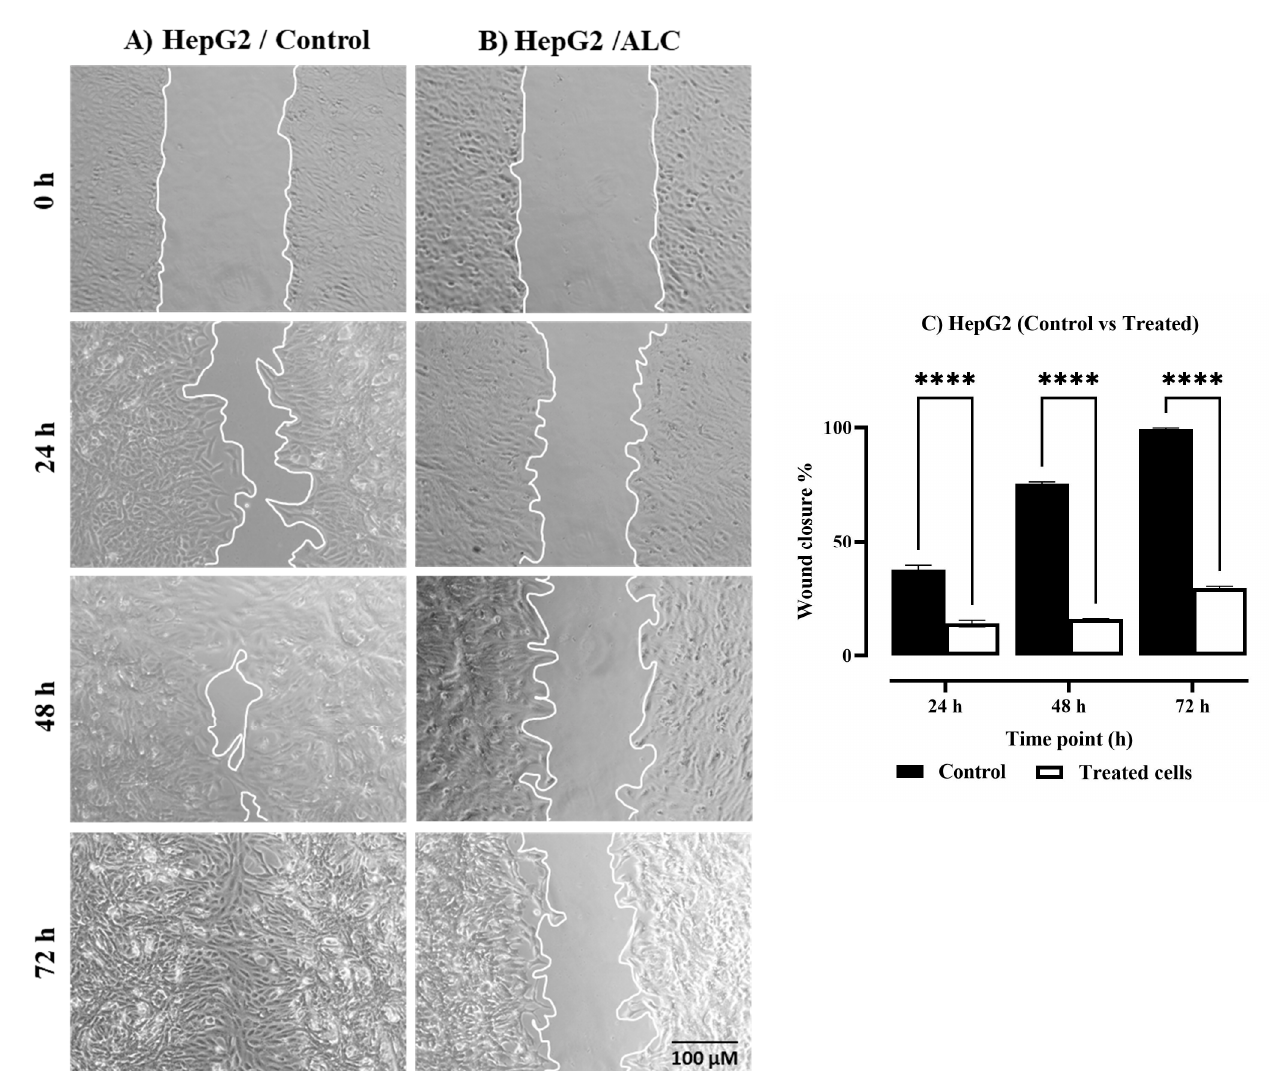
Figure 2. The effect of ALC treatment on wound closure in HepG2 cells at 0, 24, 48, and 72 h. ( A ) Control HepG2 cells, ( B ) ALC-treated HepG2 cells. HepG2 cells were treated with their IC 50 of ALC, and brightfield images were acquired at 0, 24, 48, and 72 h using an inverted microscope with a 10× objective lens. ( C ) A summary of the wound-healing assay's findings. ImageJ was used to measure the wound closure percentage. Two-way ANOVA analysis was performed to compare the wound closure percentage for control vs. treated cells. The error bars correspond to SD, **** p < 0.0001.